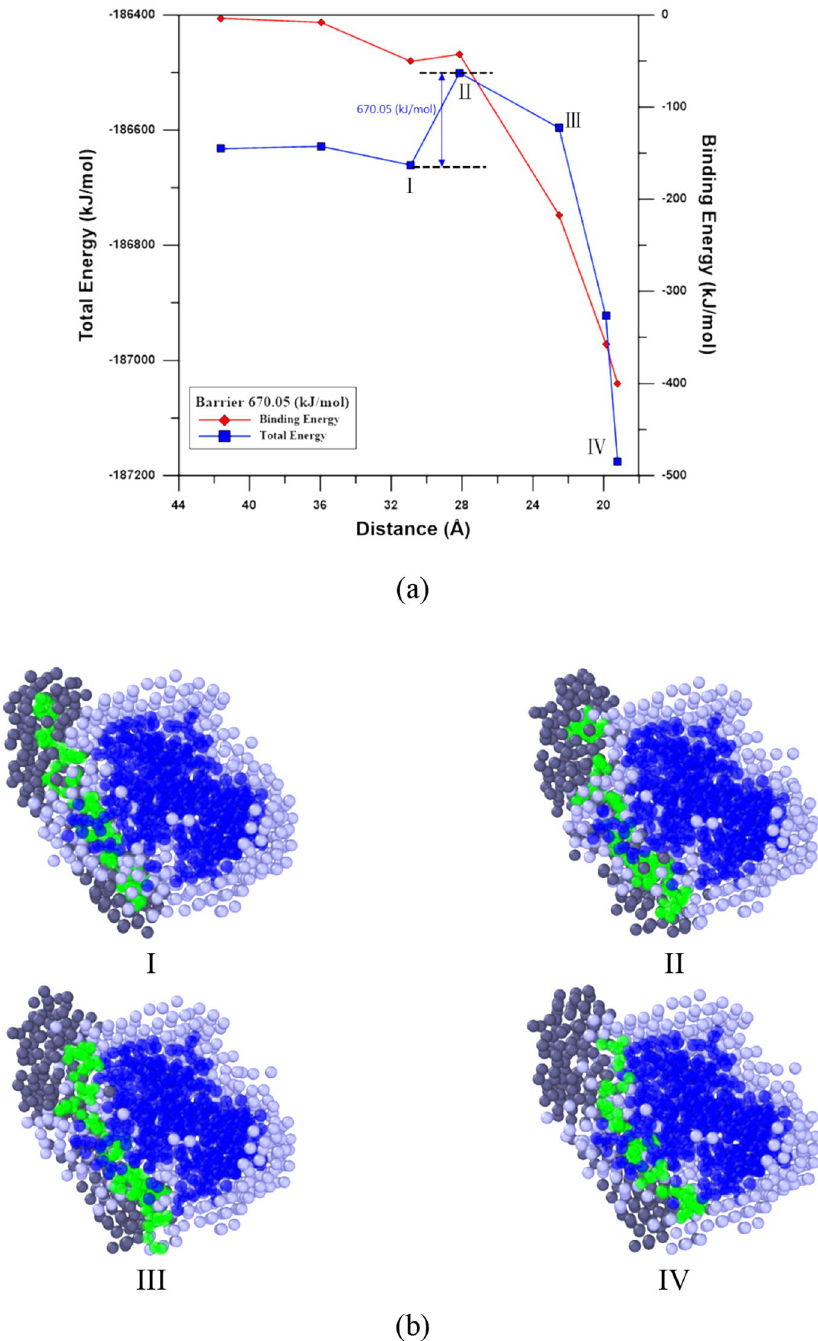
Figure 7. ( a ) Total energy and binding energy profiles with the center-of-mass distance between Apt EpA and EpCAM for CG_Case2 during the NEB process. ( b ) The slice plane views of water bead distribution within 10 Å from Apt EpA. Morphologies I to IV correspond to structures as labelled in the NEB profile. The Apt EpA , EpCAM, water beads surrounding Apt EpA and water beads surrounding EpCAM are marked in green, dark blue, dark gray, and light gray,